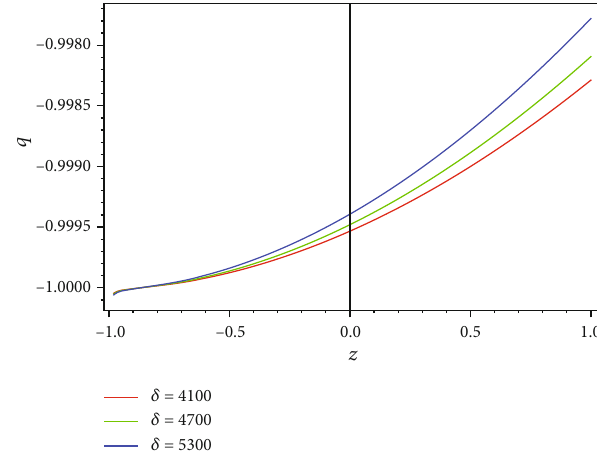
Figure 8: Variation of squared speed of sound C 2 parameter z .